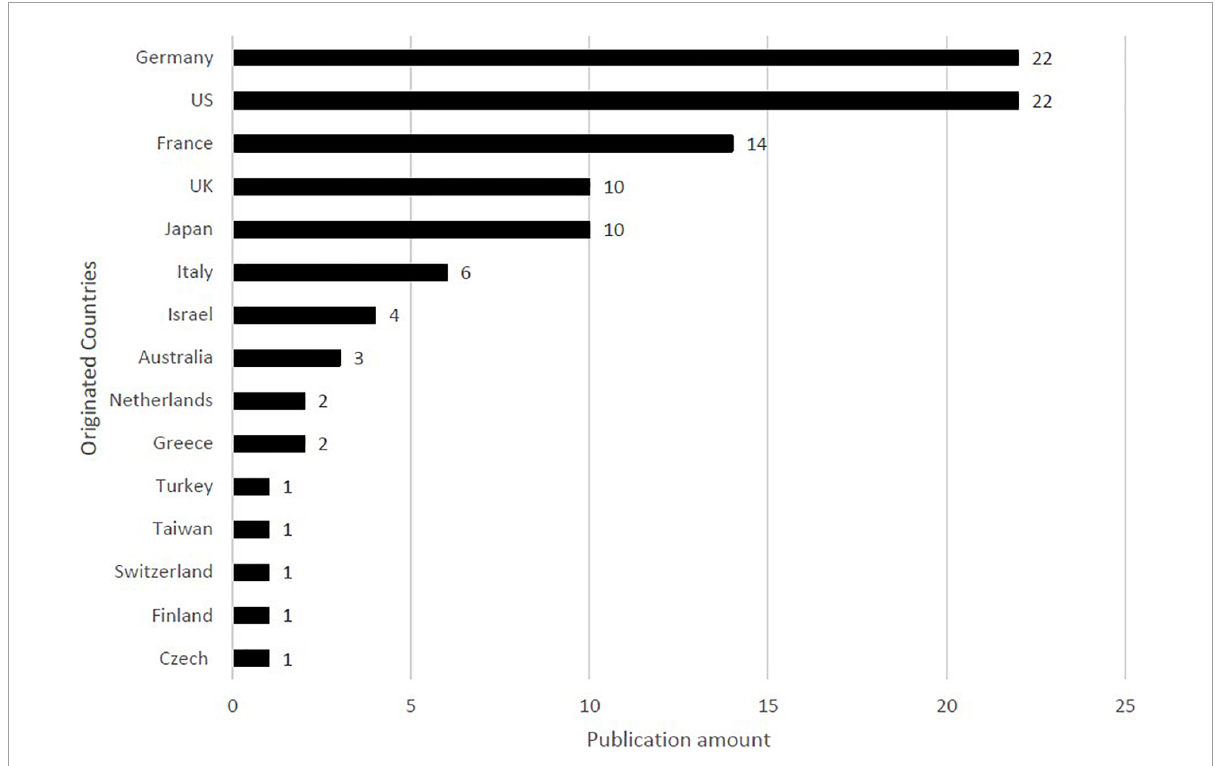
FIGURE3 Countries and regions the top 100 most-cited studies of pemphigoid diseases